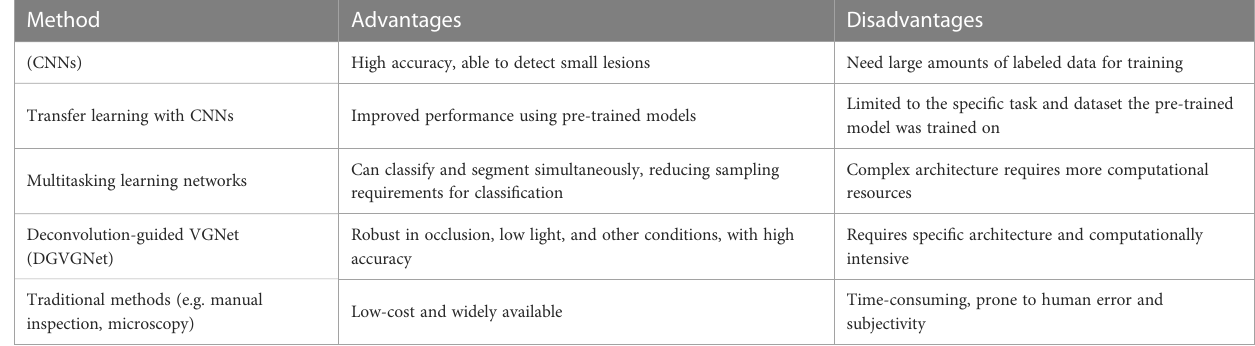
TABLE 3 Comparison of pros and cons of various object detection and classi fi cation methods for plant leaf disease